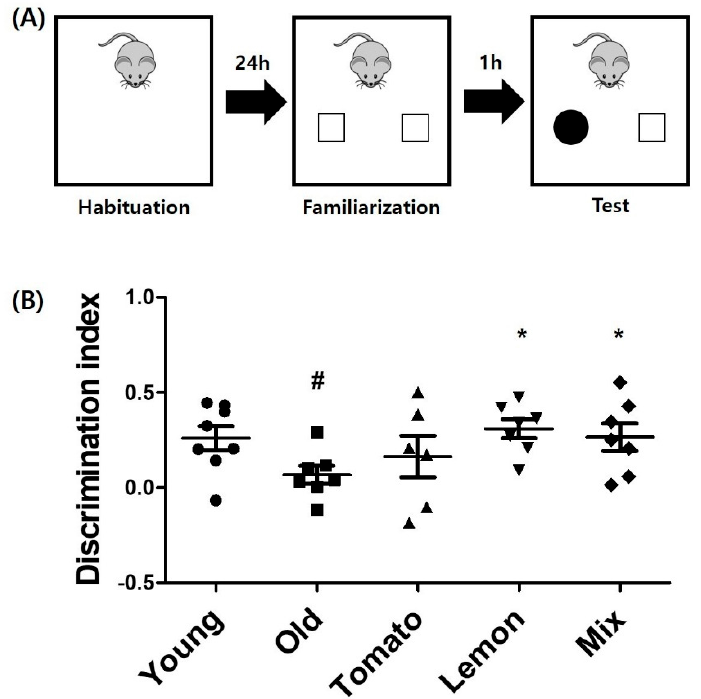
Figure 2. Enhanced novel object recognition by tomato, lemon or mixture extracts. ( A ) Novel objective recognition test. Mice were allowed to explore the open field box for habituation, and two identical objects were placed in the box for familiarization. One hour after familiarization, one object was replaced with new object and novel object recognition test was performed for 5 min. ( B ) Time spent to explore novel object was measured for each group. One-year-old mice showed significantly shorter duration of curiosity than young mice. The mixture ingested group showed significantly increased interest for new object, compared to old control group. # p < 0.01 vs. young mice, * p < 0.05 vs. old control group. n = 8 for each groups. Discrimination index (DI) was depicted at the bottom. DI allows discrimination between the novel and familiar objects and is calculated as the difference in exploration time for familiar object divided by the total amount of exploration of the novel and familiar objects [DI = (T novel − T familiar )/T novel + T familiar ].